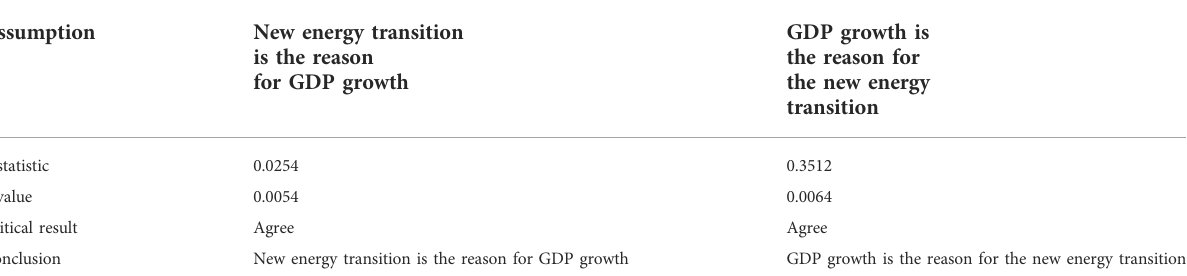
TABLE 5 Causality check.